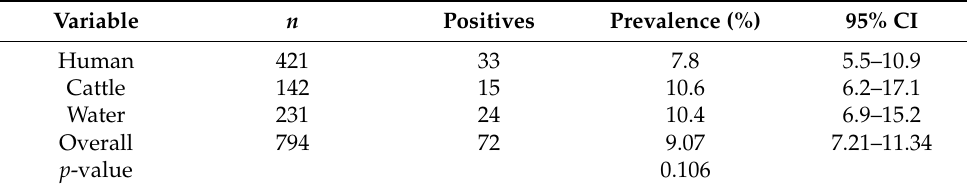
Table 4. Prevalence of NTM in humans, cattle, and